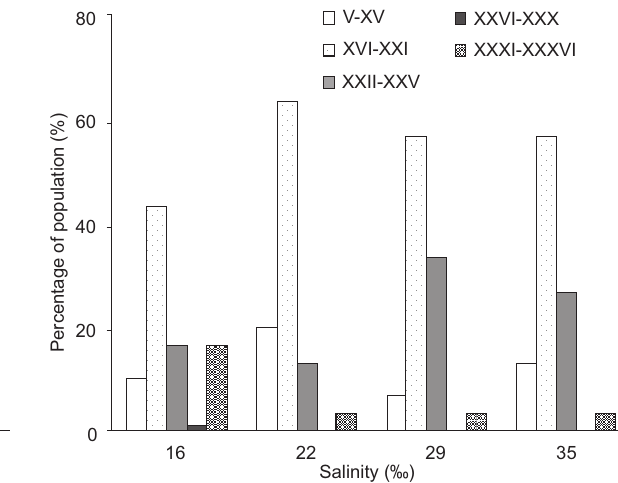
Figure 1. Stage of development (number of molts including meta- morphosis, in roman numerals) of F. paulensis postlarvae (PL after acclimation from a salinity of 30‰ to different test salinities (16, 22, 29, and 35‰) at 24.7 ± 1.6°C and 388 ind/m 2 .